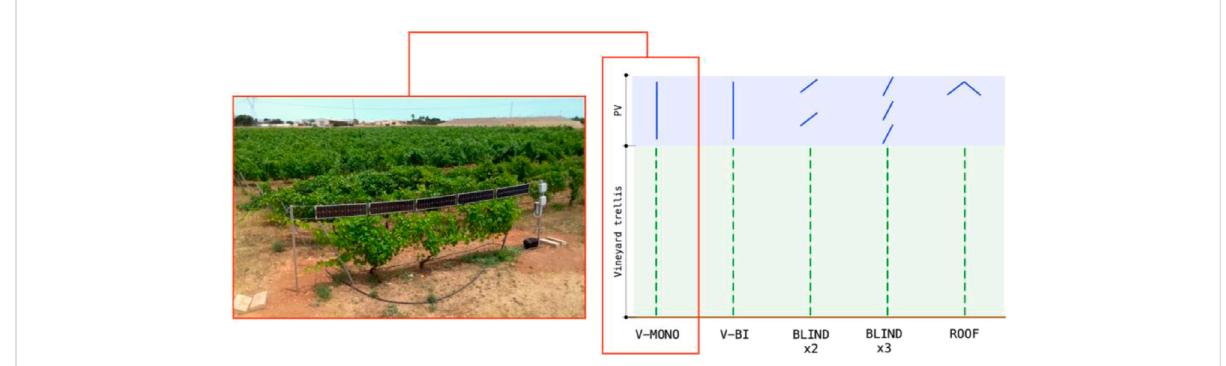
FIGURE 4 Schematic PV con fi gurations proposed. Picture shows a proof-of-concept installation for one of the proposed con fi gurations